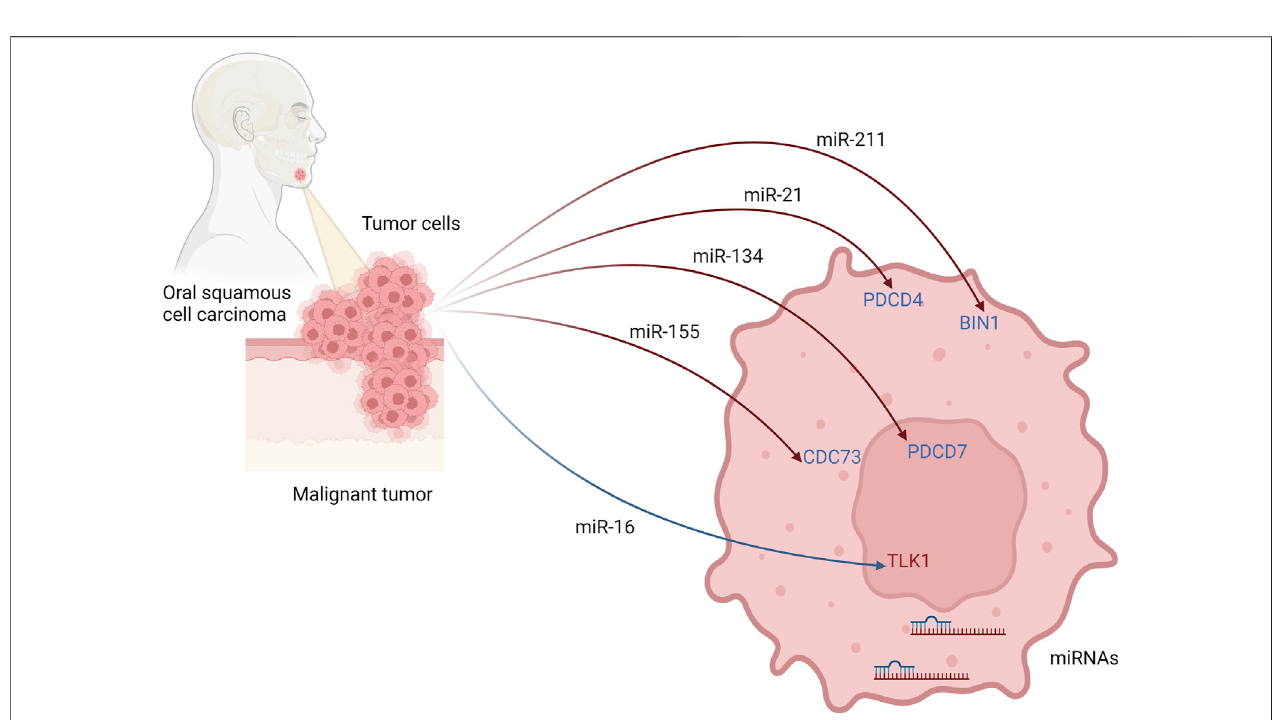
FIGURE 3 | Possible regulatory mechanism of miRNAs and their targeted genes to initiate invasive behaviour of oral squamous cell carcinoma. Created with BioRender.com.